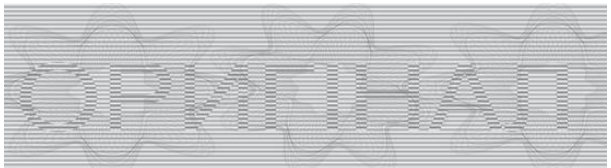
Figure 7. Creating a security element.